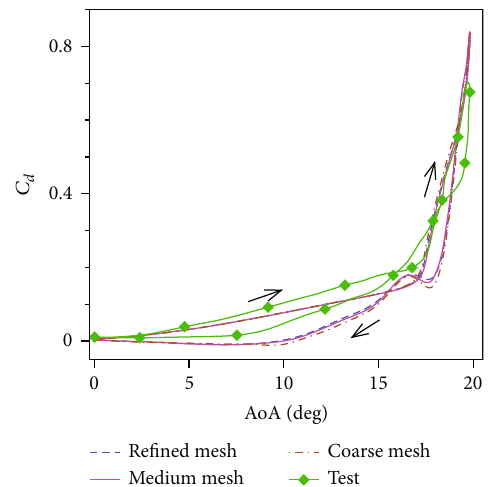
Figure 6: Comparison of drag coe ffi cients between the numerical and test